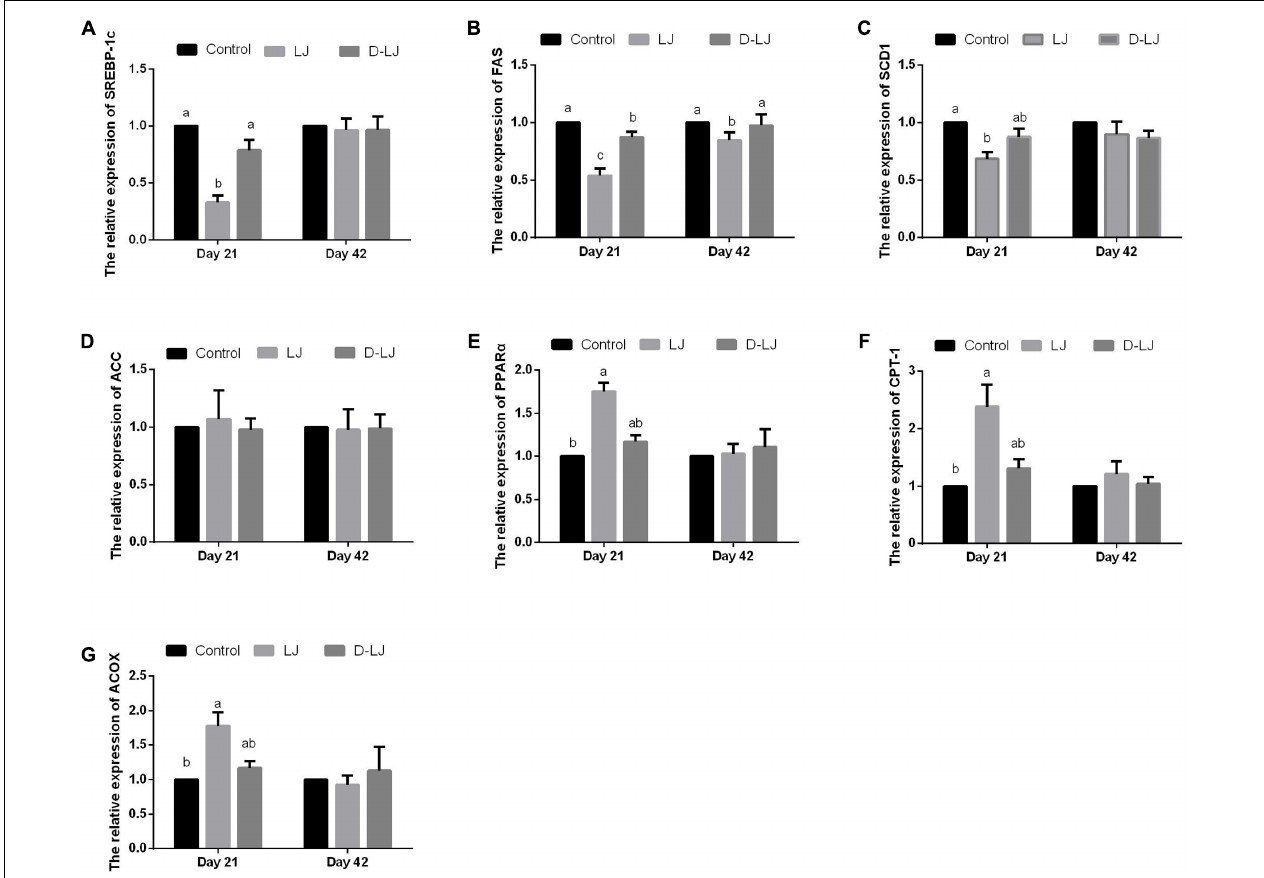
FIGURE 3 | Relative mRNA expression levels of lipid metabolism-related enzymes in the liver. Bars with different letters are significantly different in accordance with Duncan’s multiple range tests ( P < 0.05). Data are presented as mean ± standard deviation (six replicates of one chick per cage). (A–G) Relative expression of SREBP-1c, FAS, SCD1, ACC, PPAR α , CPT-1, and ACOX, respectively. SREBP-1c, sterol regulatory element binding protein-1c; FAS, fatty acid synthase; SCD1, stearoyl-CoA desaturase-1; ACC, acetyl-CoA carboxylase; PPAR α , peroxisome proliferator-activated receptor α ; and CPT-1, carnitine palmitoyltransferase-1; ACOX, acyl-CoA